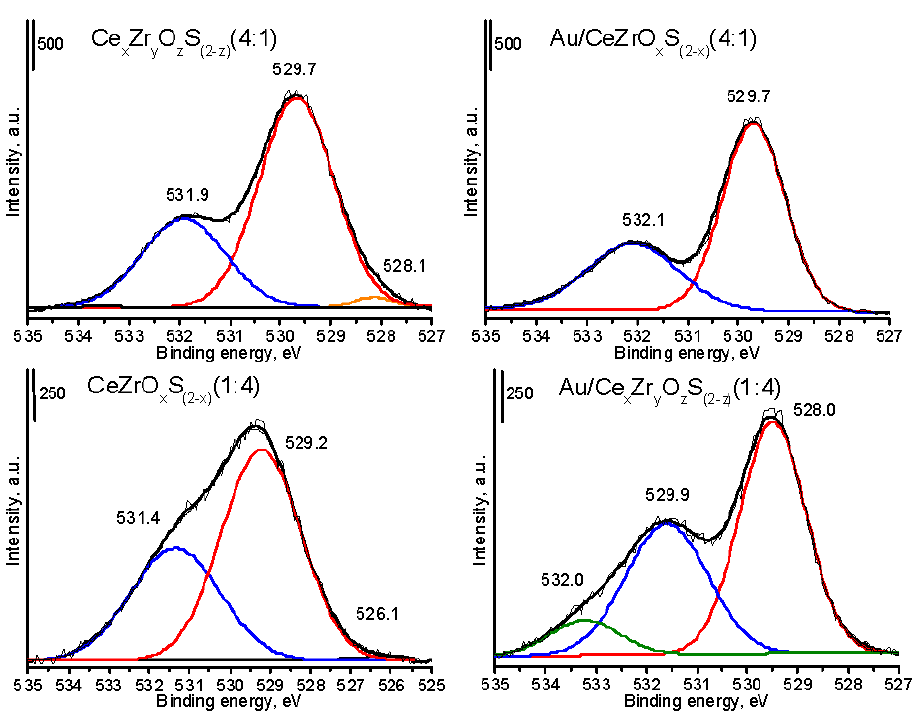
Figure 3. XP spectra recorded for O 1s species for selected Ce-Zr oxides before and after modification with Au.